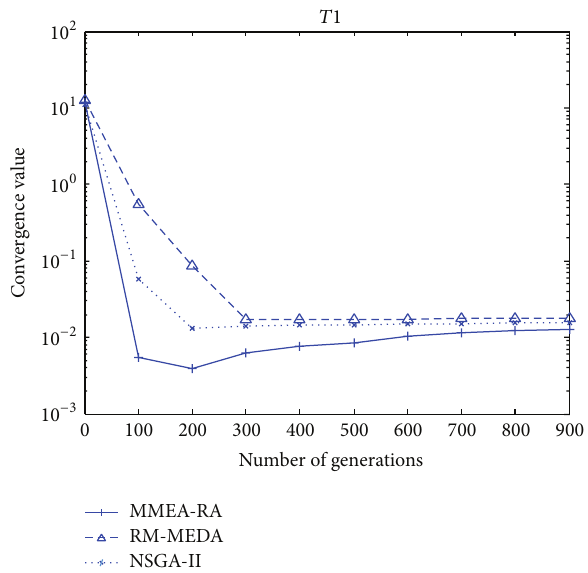
Figure 7: The evolution of the average 𝛾 -metric of the nondomi- nated solutions in three algorithms for 𝑇1 .